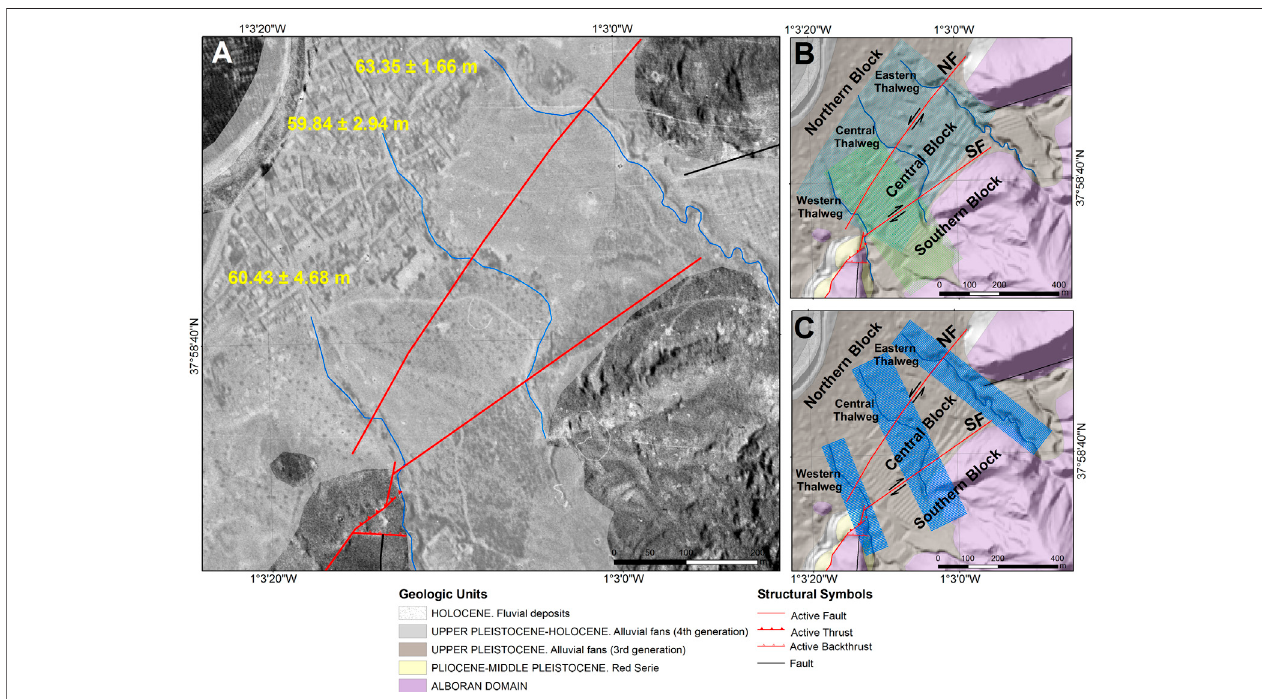
FIGURE5|(A) Mapshowingthedisplacedelementsandtheirsrecti fi cationsonthefaulttracesinterpretedontheaerialphotographobtainedduringtheyear1945 (blacklines:channeledges;bluelines:thalwegs;whitedottedlines:channeledgetrendrecti fi cations;whitedashedlines:channeledgerecti fi cations;yellowdottedlines: thalwegtrendrecti fi cations; yellowdashedlines:thalwegrecti fi cations).Lateraldisplacement measurements. (B) Locationoftheswathpro fi lesperpendiculartothefault traces (blue lines: perpendicular to the northern fault -NF- and green lines: perpendicular to the southern fault -SF). The thalwegs of the displaced channels are marked in dark blue. (C) Location of the swath pro fi les longitudinal to the thalwegs.